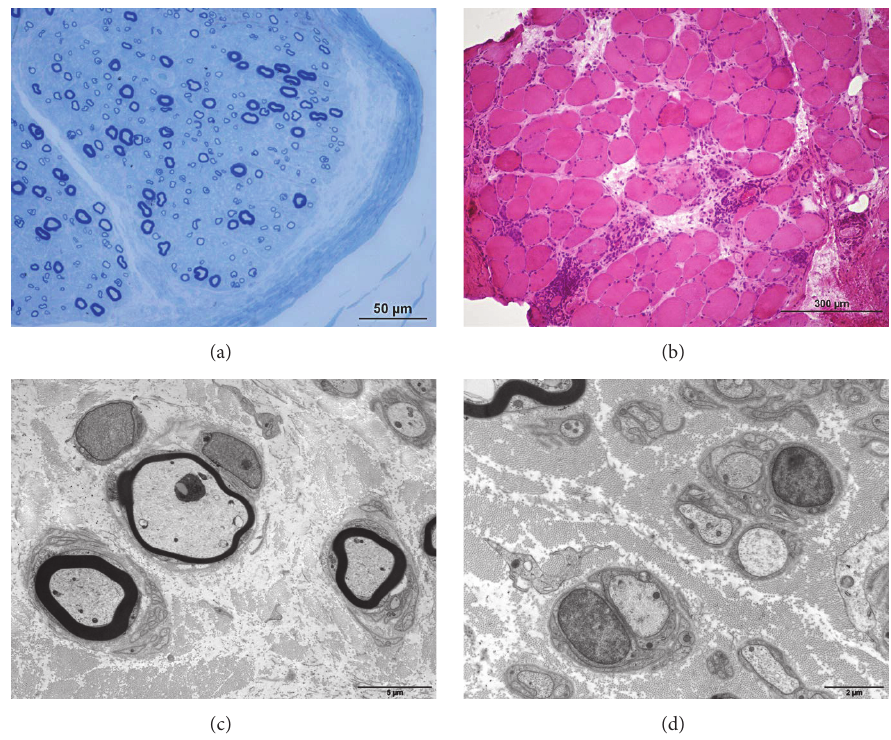
Figure 1: Pathological findings in patient 1. (a) Transverse semithin section of sural nerve stained with Toluidine Blue: there is a moderate loss of myelinated fibers. Only a few fibers have a too thin myelin sheath compared to their axonal diameter. (b) Frozen section of deltoid muscle stained with hematein-eosin showing important infiltrates of mononuclear cells; the immunostaining confirmed that these cells were mostly T cells and macrophages. (c) Electron micrograph of a sural nerve section showing two fibers surrounded by onion bulb formation and a fiber with a thin myelin sheath. (d) Electron micrograph of a sural nerve section showing an axon that has been completely